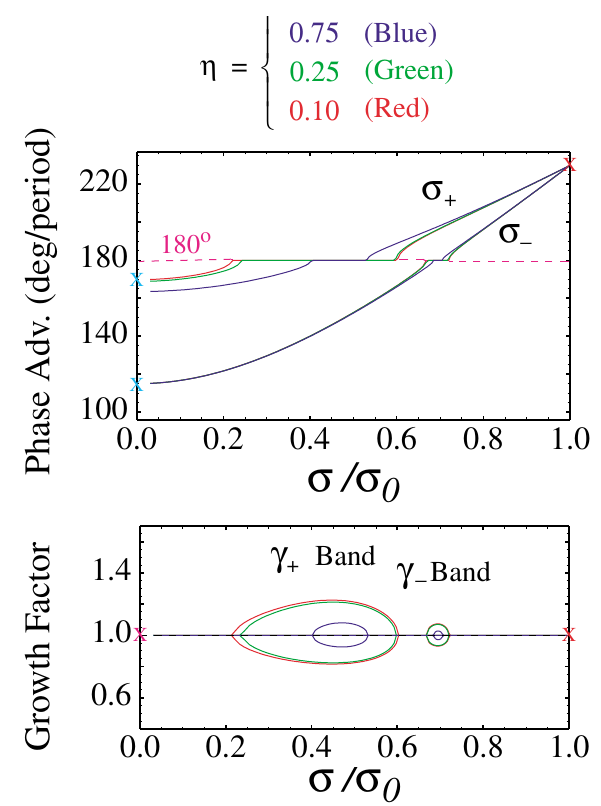
FIG. 14. (Color) Variation of mode structure with solenoid occupancy (cid:31) . Phase advance ( (cid:24) (cid:16) ) and growth factors ( (cid:6) (cid:16) ) of the breathing and quadrupole modes are plotted versus (cid:24)=(cid:24) (cid:1) 115 (cid:31) and the indicated values of (cid:31) . Red (cid:22) s for (cid:24) 0 mark analytical results in the zero space-charge limit